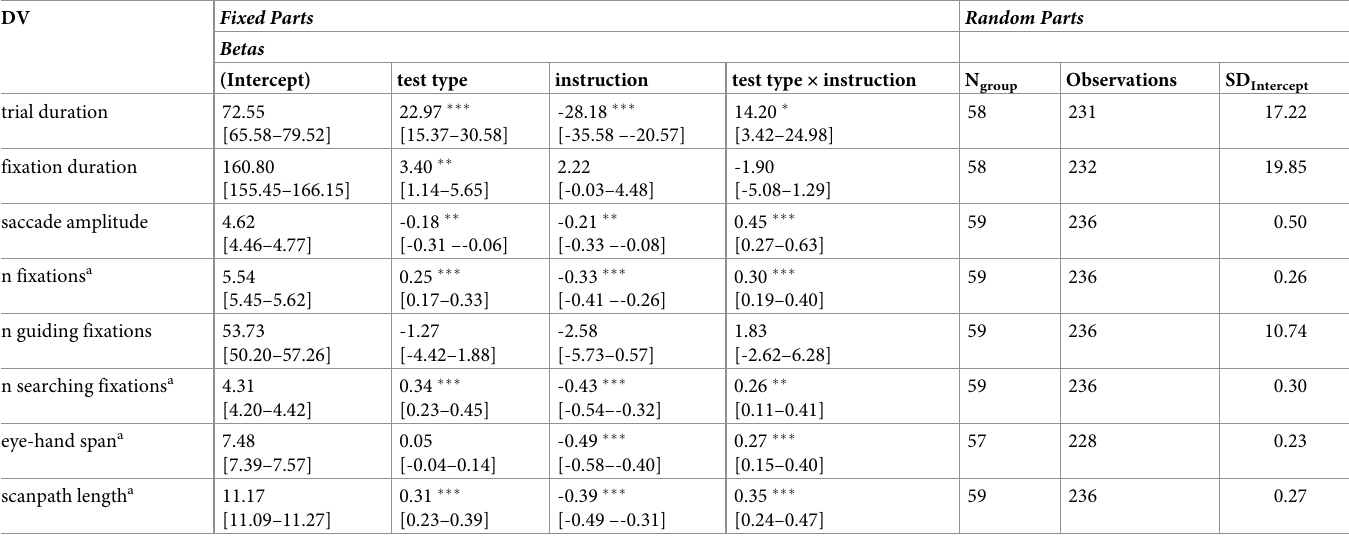
Table 1. Results of the linear mixed-effect